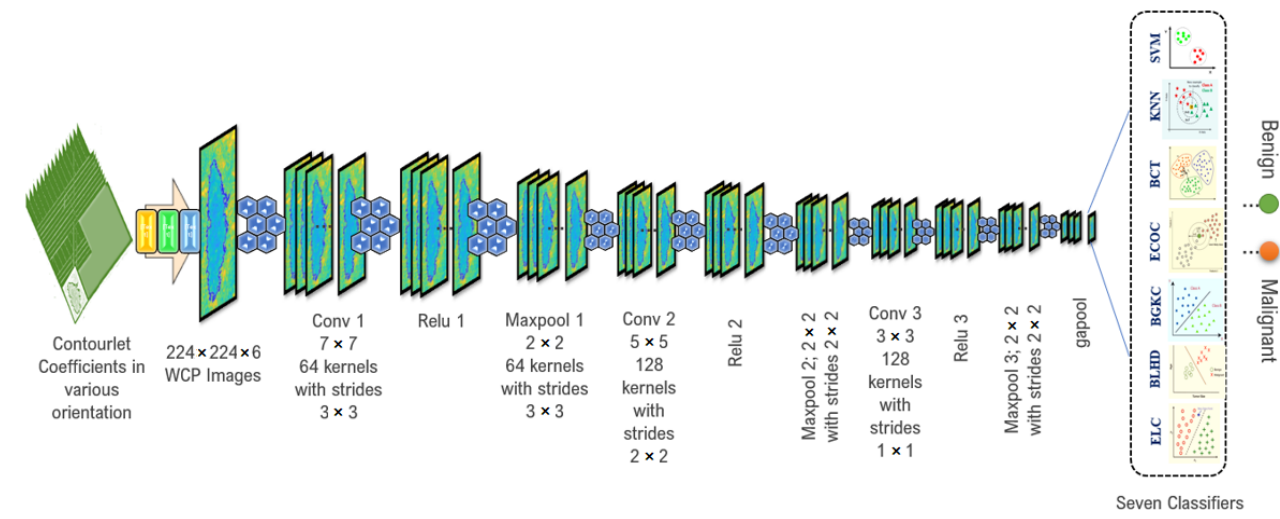
Figure 9. The proposed CNN architecture. Table 5. The Proposed CNN network configuration.